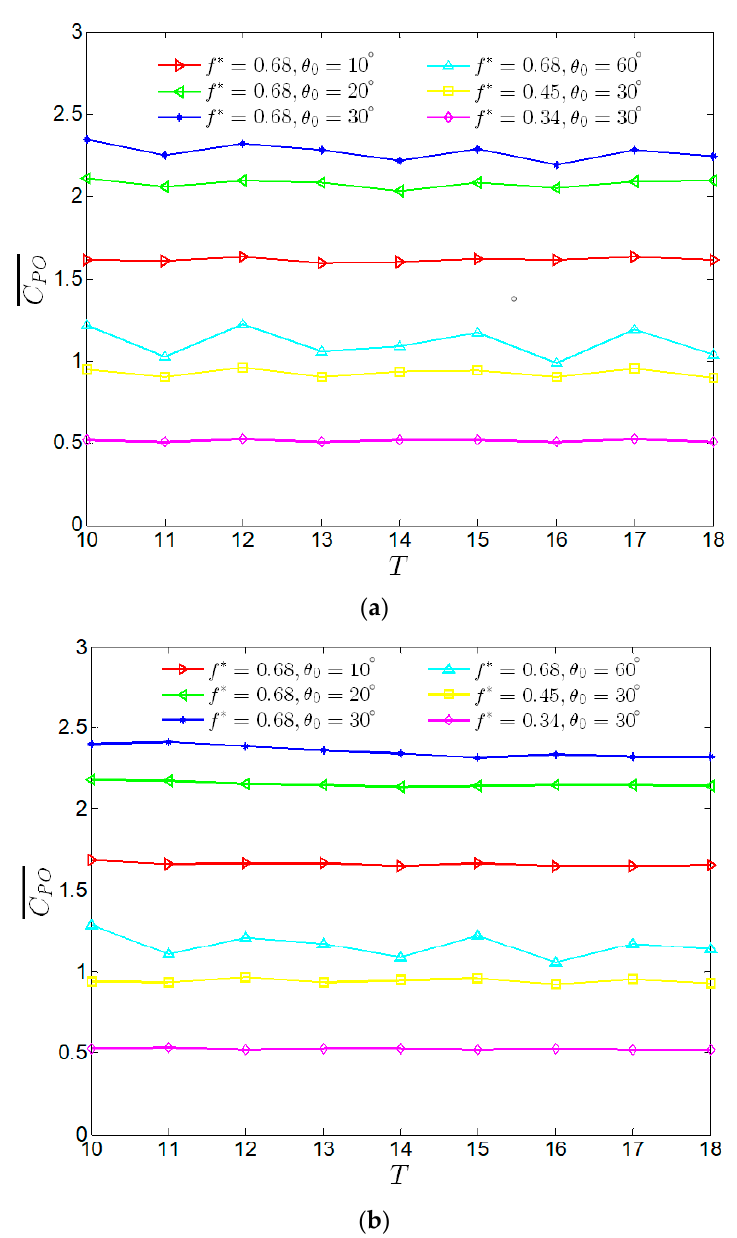
Figure 8. The evolution of the mean propulsion power coe ffi cient for di ff erent reduced frequency and pitching amplitude, ( a ) τ = 0.2, ( b ) τ =